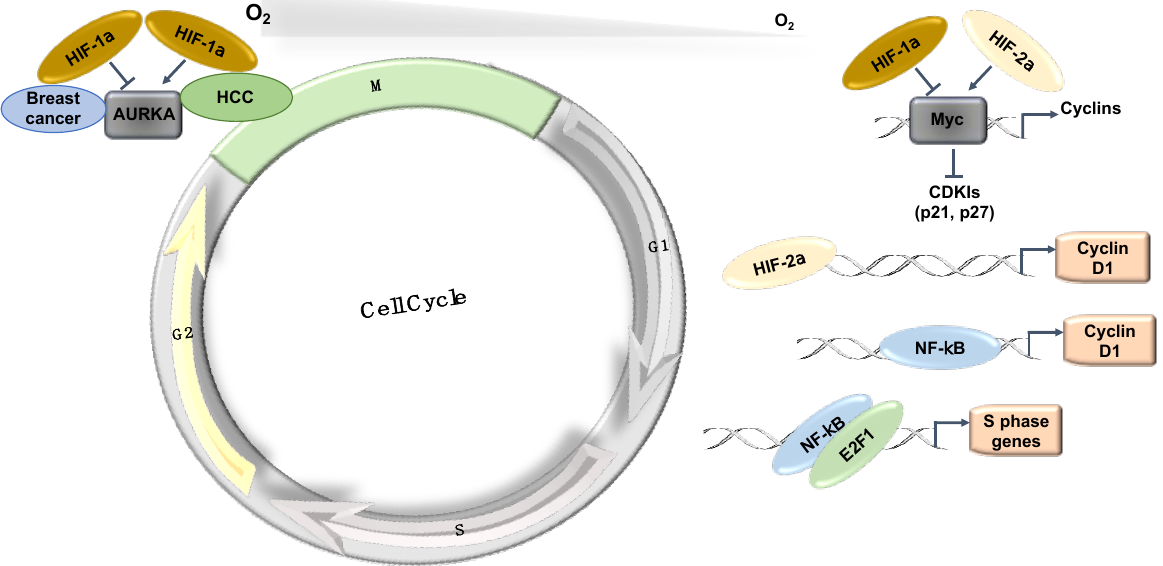
Figure 3. Hypoxia-induced transcriptional effects on the cell cycle. HIFs and NF- κ B control the expression of a number of important components of the cell cycle machinery and control mechanisms. HCC: Hepatocellular carcinoma.